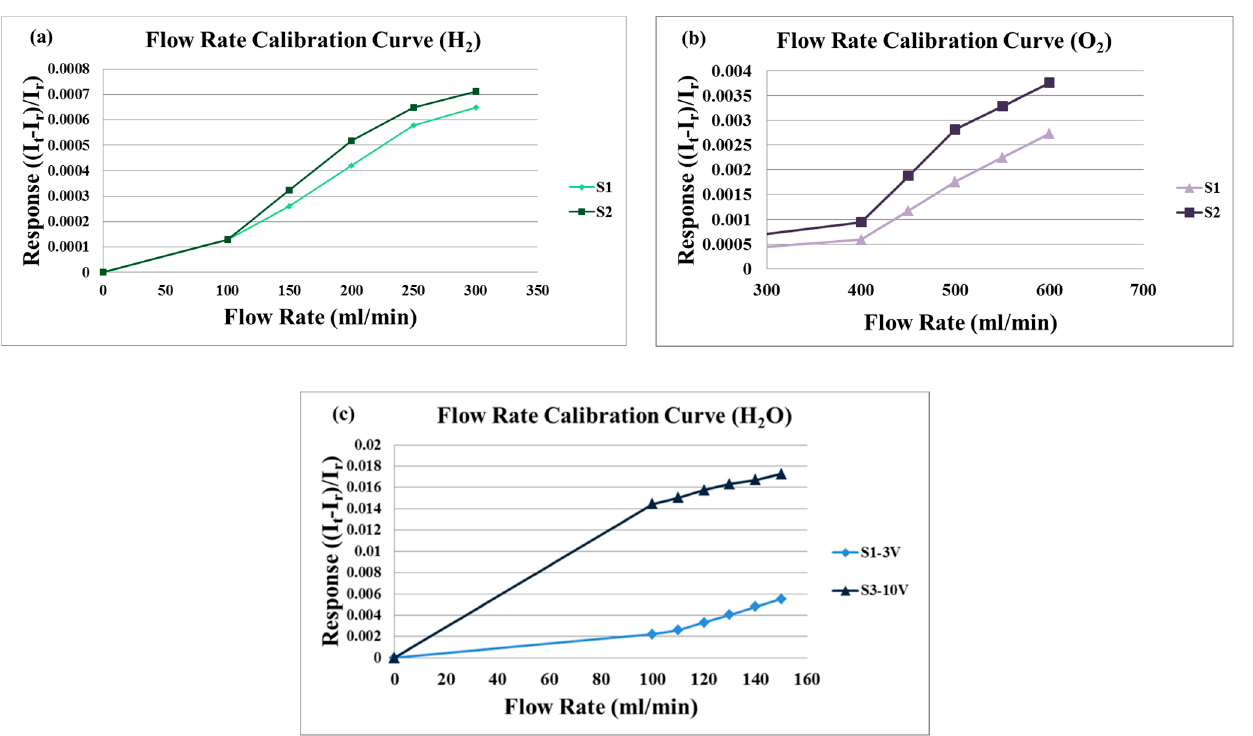
Figure 6. ( a ) The correction curve of two micro flow sensors (H 2 ). ( b ) The correction curve of two micro flow sensors (O 2 ). ( c ) The correction curve of two micro flow sensors (H 2 O).